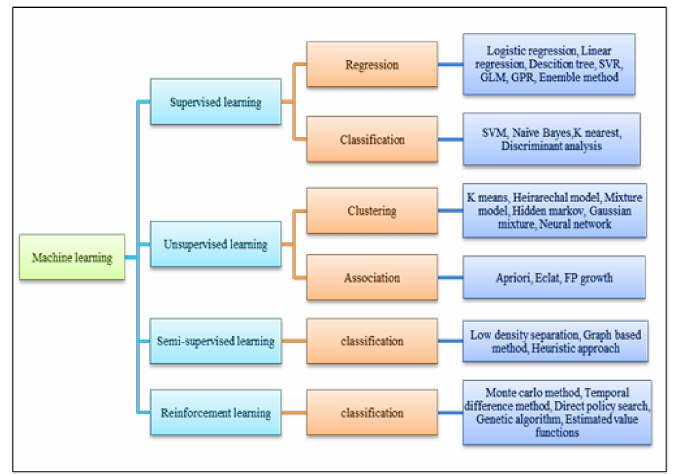
Figure 8. Machine learning algorithm